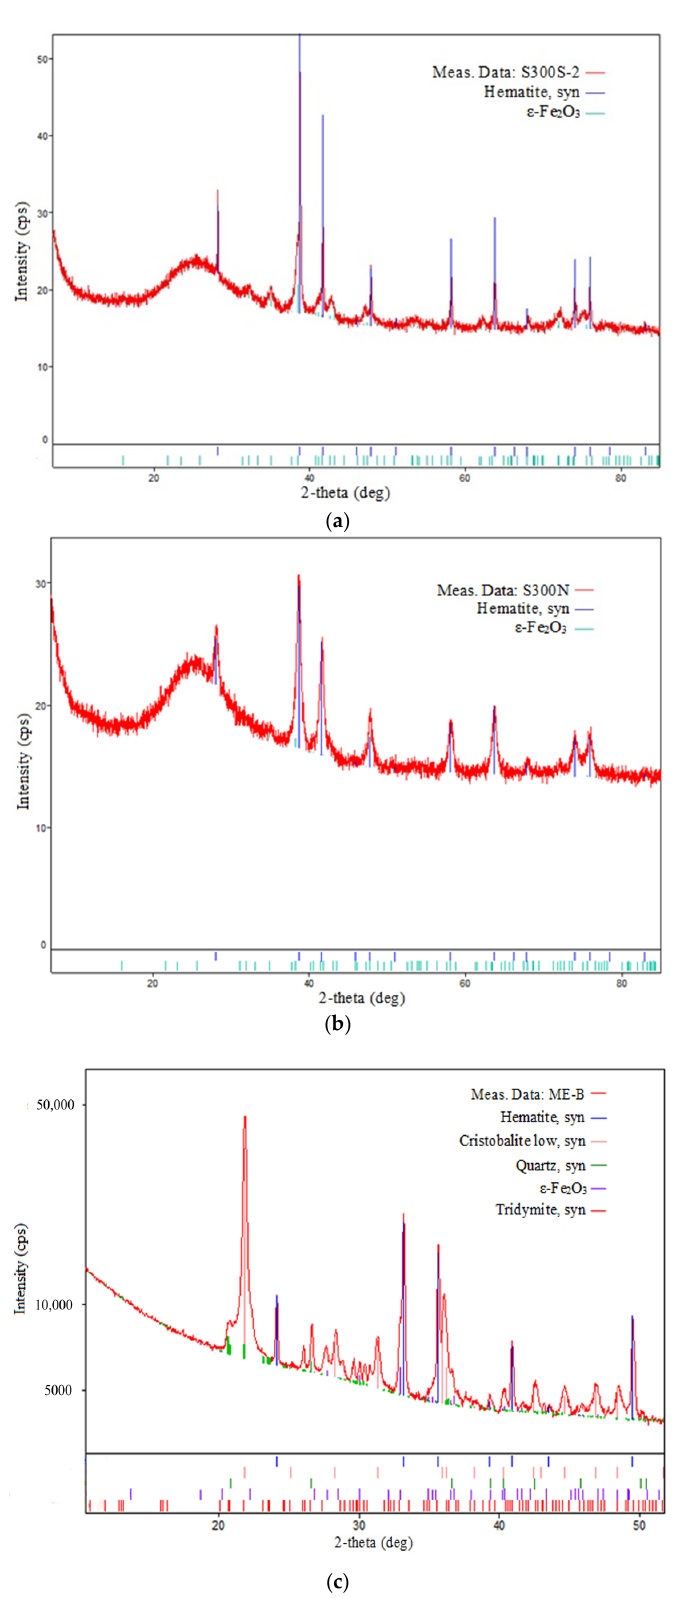
Figure 1. X-ray diffractograms: ( a ) Sample S300S-2; ( b ) Sample S300N; ( c ) Sample ME-B. PDF-2 (International Center for Diffraction Data, 2020) cards: Hematite 01-080-2377; ε -Fe 2 O 3 01-076-3272; Cristobalite 01-077-1317; Quartz 01-083-0539; Tridymite